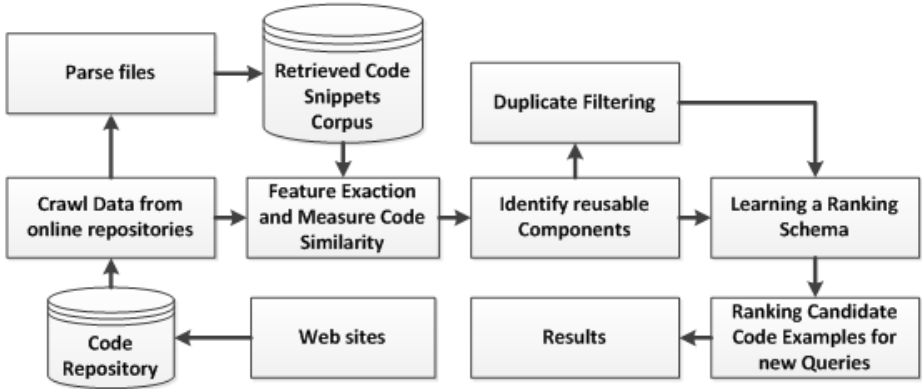
Figure 1. Proposed System Architecture.